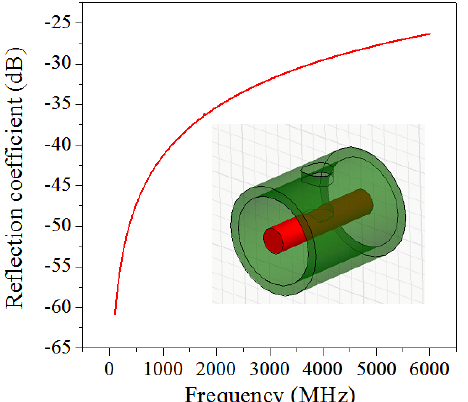
Figure 3. Calculated reflection coefficient in magnitude of the proposed reflector on a coaxial